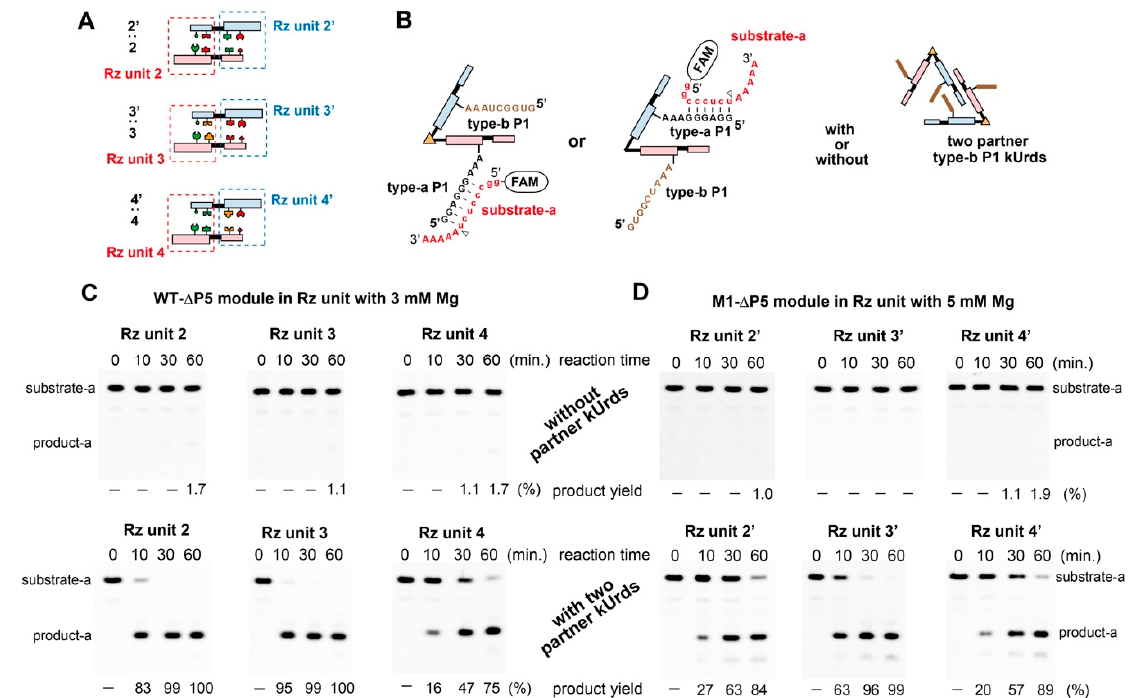
Figure 6. Activation of ribozyme unit upon assembly of kUrds. ( A ) Formation of two ribozyme units in each RzM:RzM interface. One ribozyme unit (2, 3, or 4) formed the wild-type ribozyme and the other ribozyme unit (2 ′ , 3 ′ , or 4 ′ ) formed the M1 type ribozyme. ( B ) Sequences of substrate-a and two types of P1 binding elements. Location of P1 element in the secondary structure of the Tetrahymena group I ribozyme are shown in Figure S1. ( C ) Cleavage of substrate-a by the wild-type ribozyme unit in a given kUrd without (top) or with (bottom) its partner kUrds in the presence of 3 mM Mg 2+ . ( D ) Cleavage of substrate-a by the M1 type ribozyme unit in a given kUrd without (top) or with (bottom) its partner kUrds in the presence of 5 mM Mg 2+